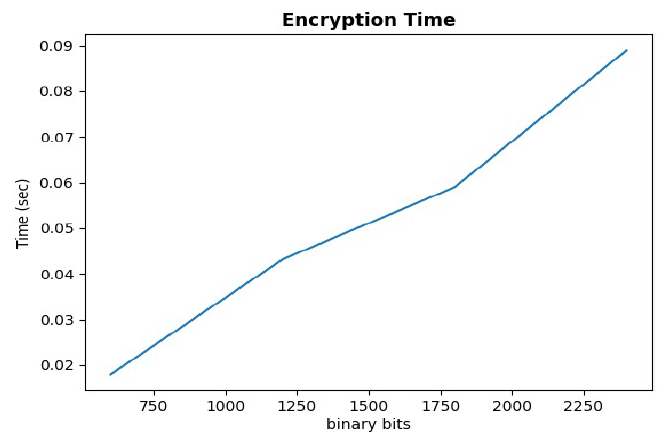
Figure 7. Computational complexity for encryption